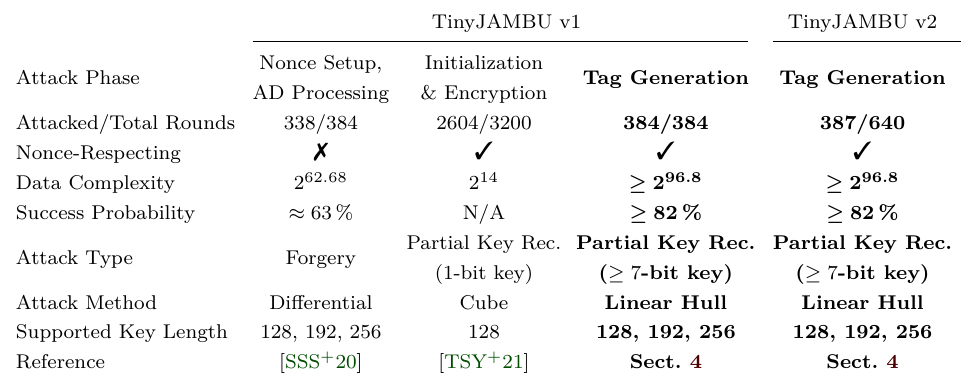
Table 2: Summary of attacks on